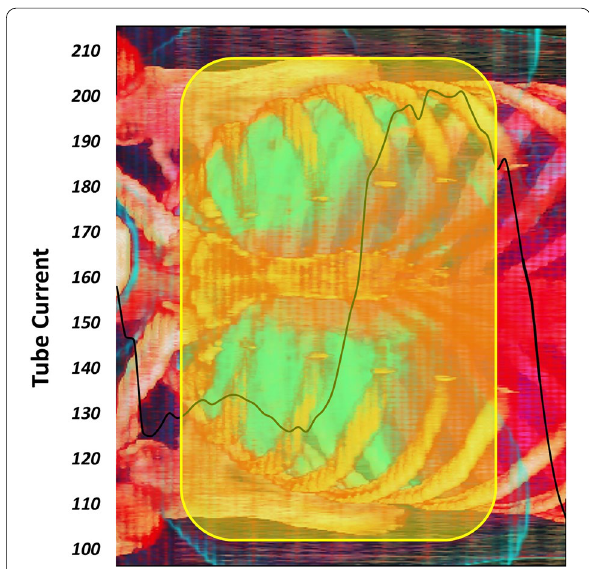
Fig. 6 Tube current pattern (black line—mA) in the craniocaudal (left to right) direction. The yellow box indicates the lung segment boundaries